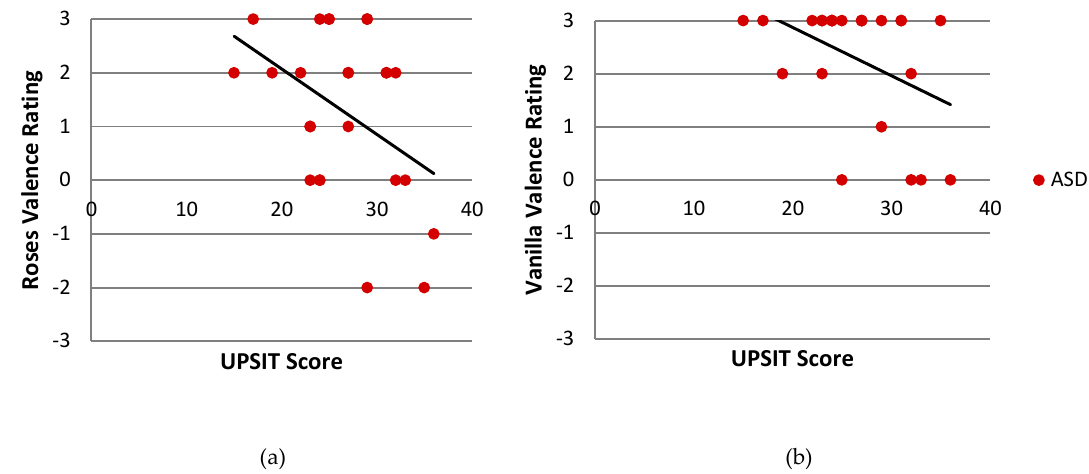
Figure 6. Within groups correlation between smell identification (UPSIT Score) and odor valence in the ASD group. Odor valence is displayed for the Roses odor ( a ) and Vanilla odor ( b ). Each point represents one individual. UPSIT = University of Pennsylvania Smell Identification Test; ASD = children with Autism Spectrum Disorder.